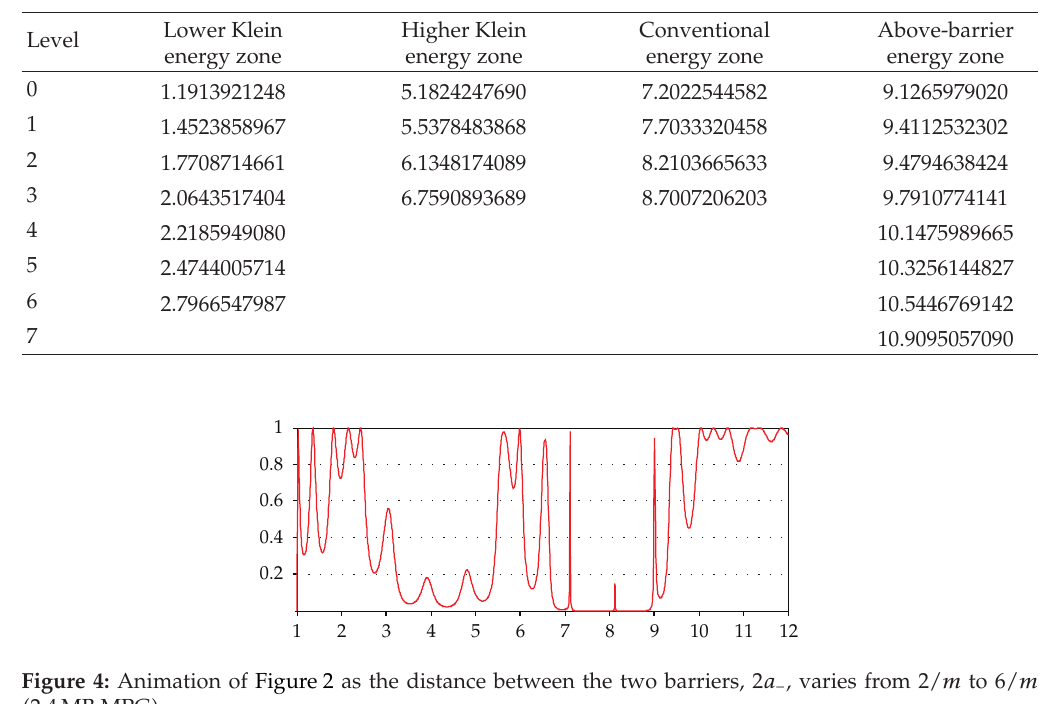
Table 1: Transmission resonance energies (cid:3) in units of mc 2 (cid:4) for the potential configuration associated with Figure 2 (cid:3) V (cid:2) (cid:9) 8 m , V − (cid:9) 4 m , a (cid:2) (cid:9) 3 /m , a − (cid:9) 2 . 5 /m (cid:4) . These values were obtained as solutions to the equation M 21 (cid:3) E (cid:4) (cid:9) 0.